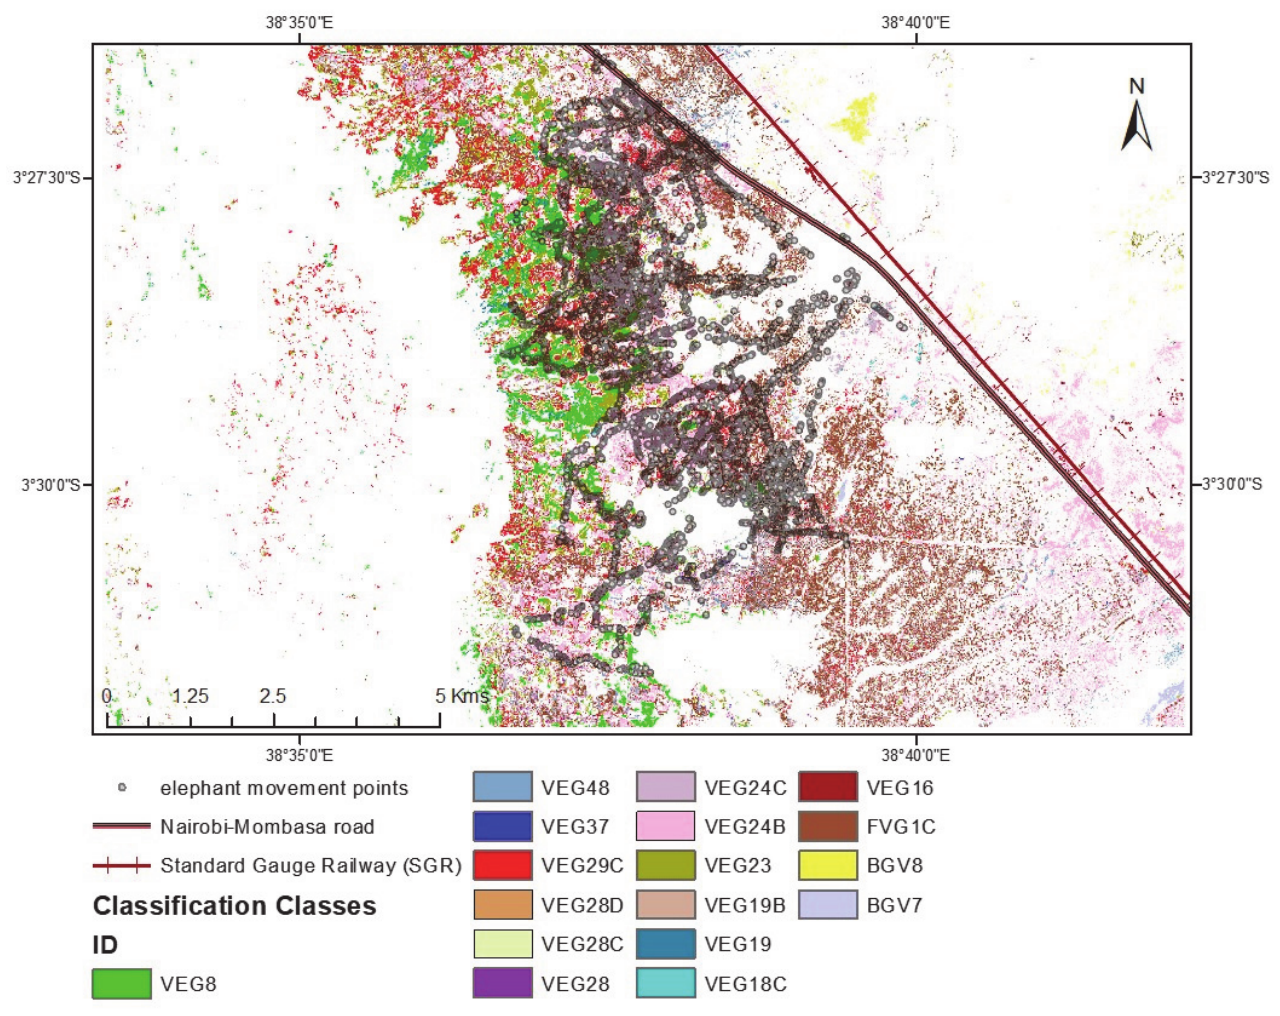
Figure 12. This map shows elephant movement points overlaid on the supervised classification output. Masked out are the other vegetation classification classes that we were not able to exhaustively determine the species’ compositions, as well as the farm areas, the permanent surfaces such as roads and railway, and bare-ground, water, and rock surfaces. Included in this map are the other vegetation classes whose ground truthing field work was conducted as per the terms described for the classes we analysed to determine vegetation composition namely: Bgv7, Bgv8, Veg19, Veg19b, Veg48, Veg28c, and Veg24c.